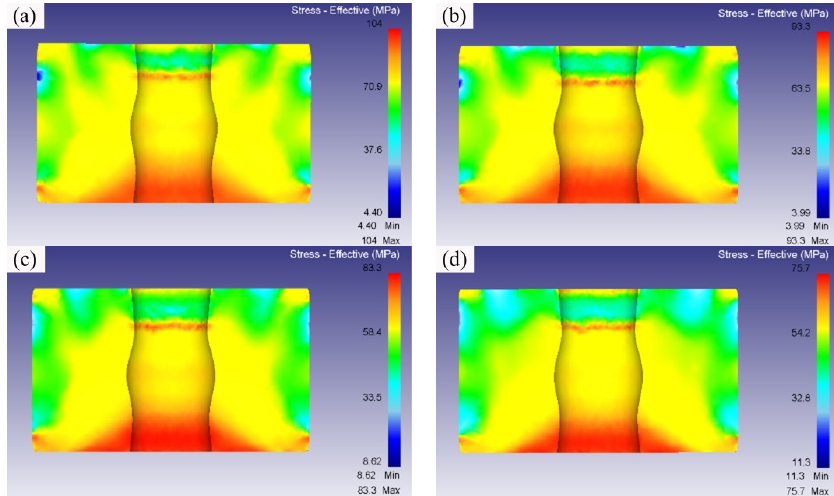
Figure 9. Stress distributions of the forming parts at different temperatures of: ( a ) 320 °C, ( b ) 340 °C, ( c ) 360 °C, ( d ) 380 °C.